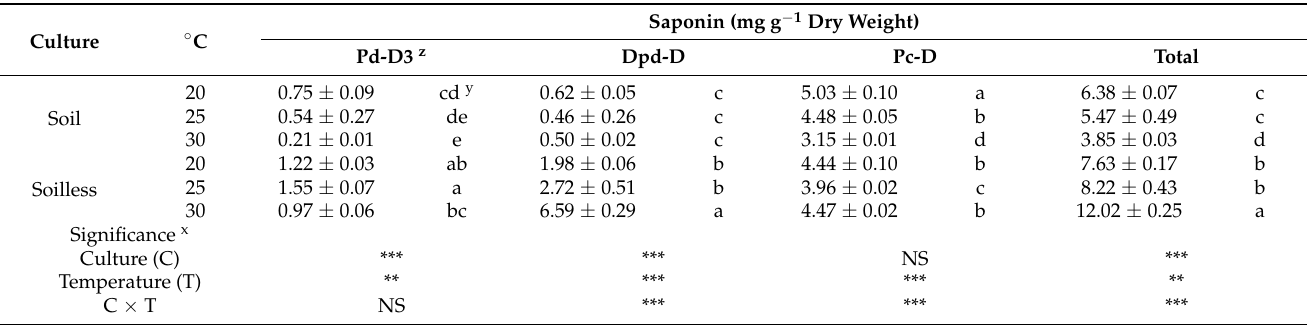
Table 2. Saponin concentrations in roots of balloon flower sprouts grown under soil and soilless culture systems with different temperatures at 17 days after